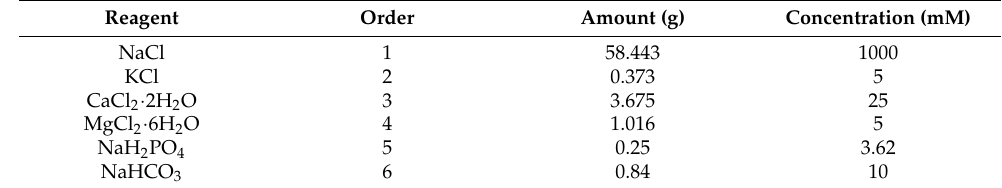
Table 1. Components of 10 × SBF-like stock solution for a total volume of 1000 mL [32]. Reagent Order Amount (g) Concentration (mM) NaCl